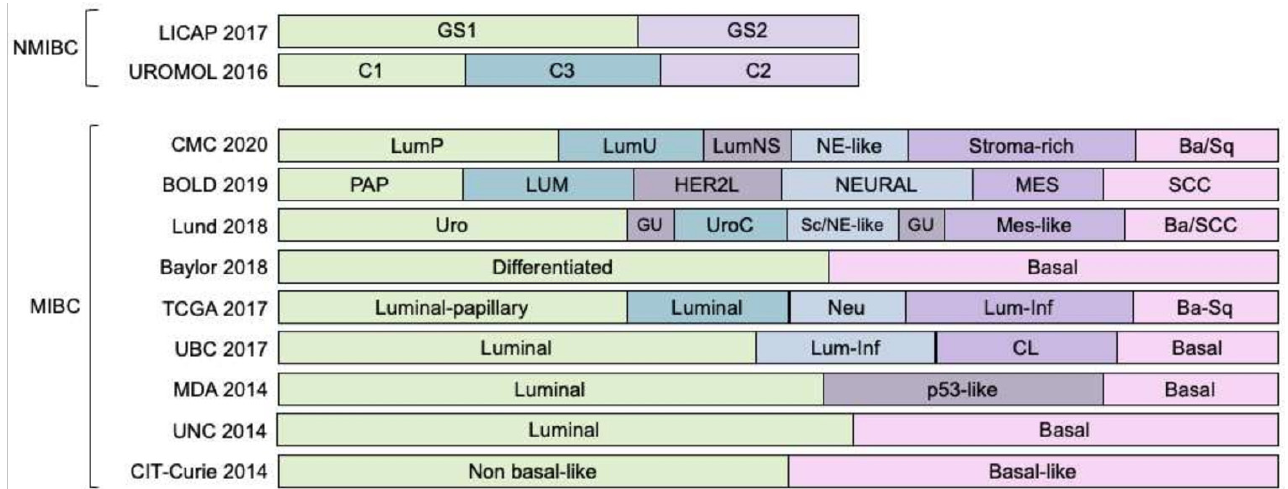
Figure 4. Schematic representation of the similarities between different molecular classifications of bladder cancer. For NMIBC, molecular subtypes were proposed by the Leeds Institute of Cancer and Pathology (LICAP 2017), and the European UROMOL project (UROMOL 2016). GS1 = genomic subtype 1, GS2 = genomic subtype 2, and C1 = class 1, C2 = class 2, C3 = class 3. For MIBC, nine molecular classifications have been suggested to date, with a consensus molecular classification presented in 2020 (CMC 2020): LumP = luminal papillary, LumU = luminal unstable, LumNS = luminal non specified, NE- like = neuroendocrine-like, Ba/Sq = basal/squamous. Cancer Science Institute of Singapore (BOLD 2019): LUM = luminal- like, PAP = papillary-like, HER2L = HER2-like, NEURAL = neural-like, MES = mesenchymal-like, SCC = squamous-cell carcinoma-like. The Lund University (Lund 2018): Uro = urothelial-like, GU = genomically unstable, UroC = urothelial-like C, Sc/NE-like = Small-cell/neuroendocrine-like, Mes-like = mesenchymal-like, Ba/SCC = basal/squamous-cell carcinoma. The Baylor College of Medicine (Baylor 2018): Differentiated, and Basal. The Cancer Genome Atlas Network (TCGA 2017): Luminal-papillary, Luminal, Neu: neuronal, Lum-Inf: luminal-infiltrated, Ba-Sq: basal-squamous. The University of British Columbia (UBC 2017): Luminal, Lum-Inf = luminal-infiltrated, CL = claudin-low, and Basal. The MD Anderson Cancer Center (MDA 2014): Luminal, p53-like, and Basal. The University of North Carolina (UNC): Luminal, and Basal. The Institut Curie (CIT-Curie 2014): Non-basal-like, and basal-like